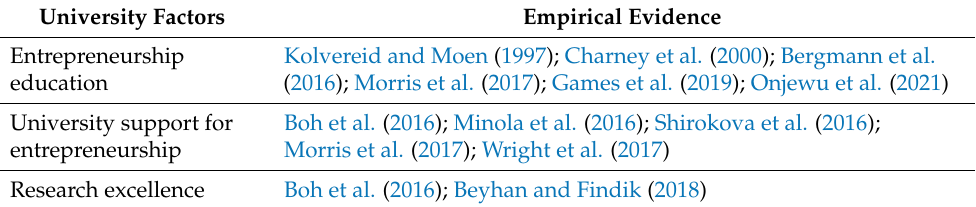
Table 1. University factors affecting students and graduates’ involvement in nascent entrepreneur-